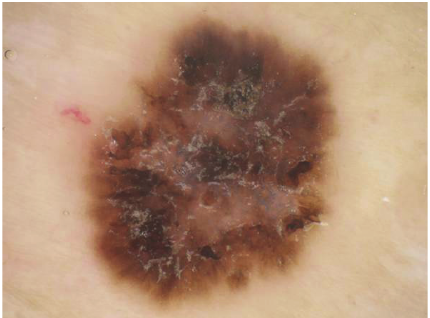
Figure 3: Hematoxylin and eosin staining revealed marked acanthosis with hyperkeratosis and irregular melanin pigment distribution throughout the epidermis to papillary dermis. The papillary dermis showed a dense infiltrate of lymphocytes and numerous scattered melanophages.